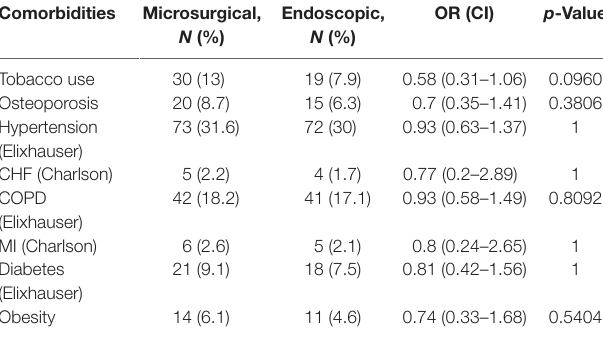
Table 3 | Patient comorbidities.